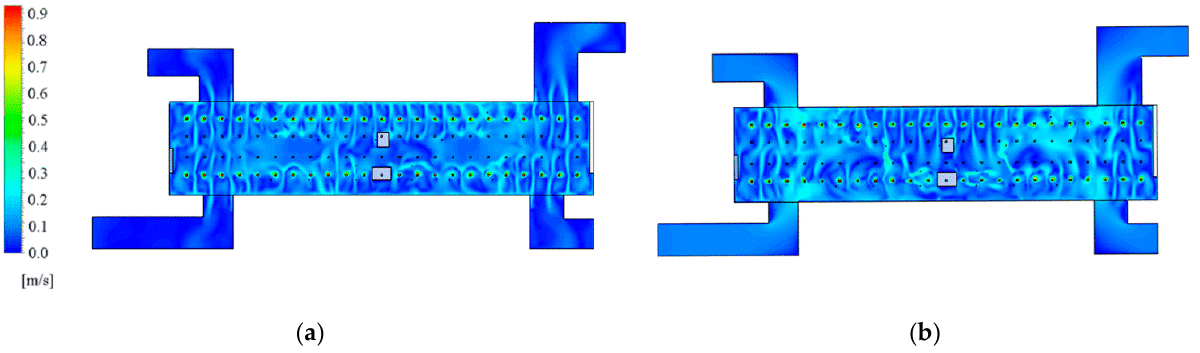
Figure 12. Simulation results of the airflow field at the station concourse floor under different airflow organization: ( a ) PSDs closed; ( b ) PSDs opened.